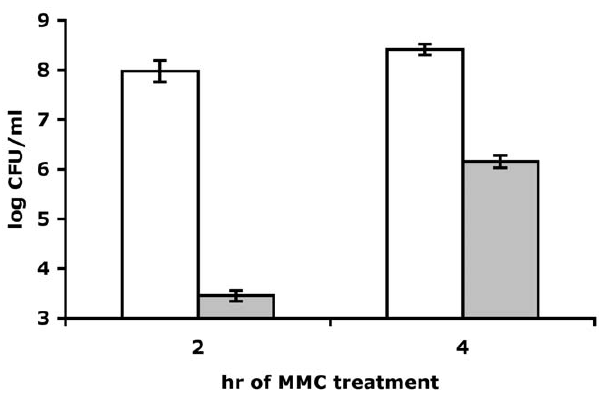
Figure 5. Mitomycin C-induced persistence. Wild-type cells in exponential phase were treated with mitomycin C for either 2 or 4 hours before being exposed to 0.3 m g/ml ciprofloxacin. Open bars; total viable counts, gray bars; persister fraction. The data are averages of 3 independent experiments and error bars indicate standard error.